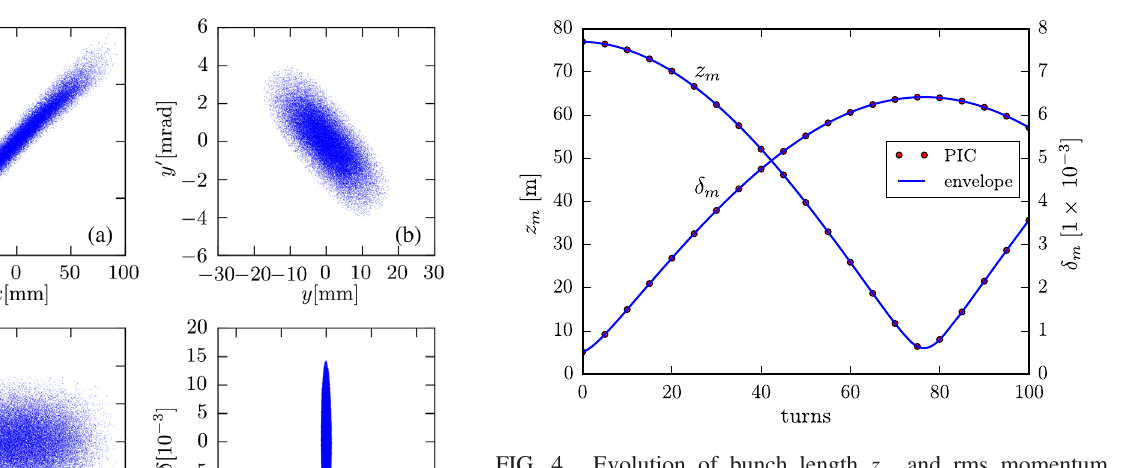
and rms momentum m